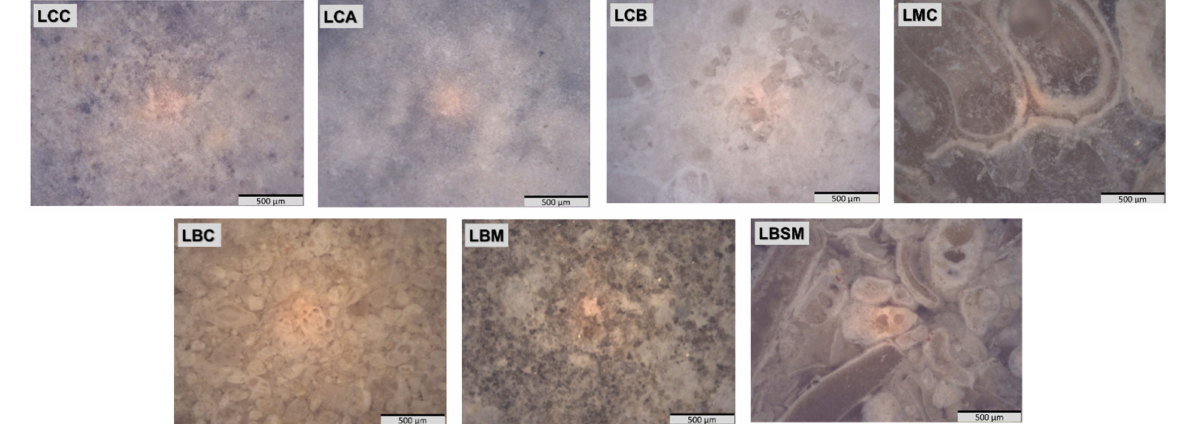
Figure 6. Optical stereomicrographs obtained from the surface of